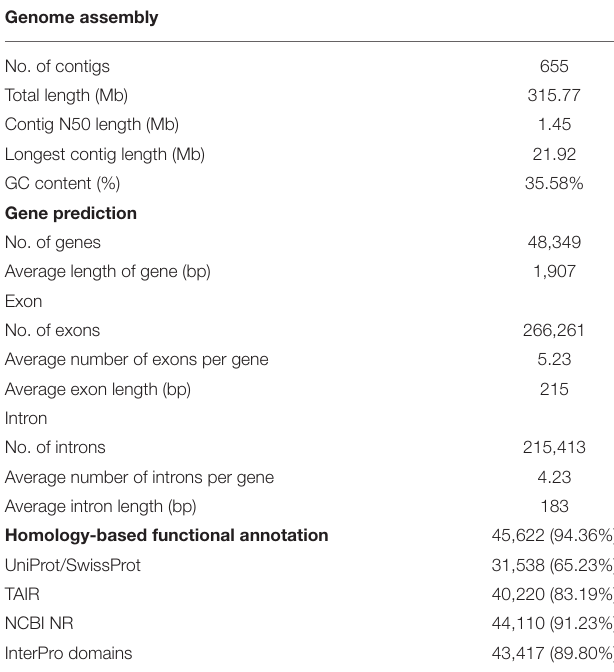
showing large genome variations among B. rapa subspecies ( Supplementary Figure 7 ). Additionally, 3,795,367 SNPs, with a